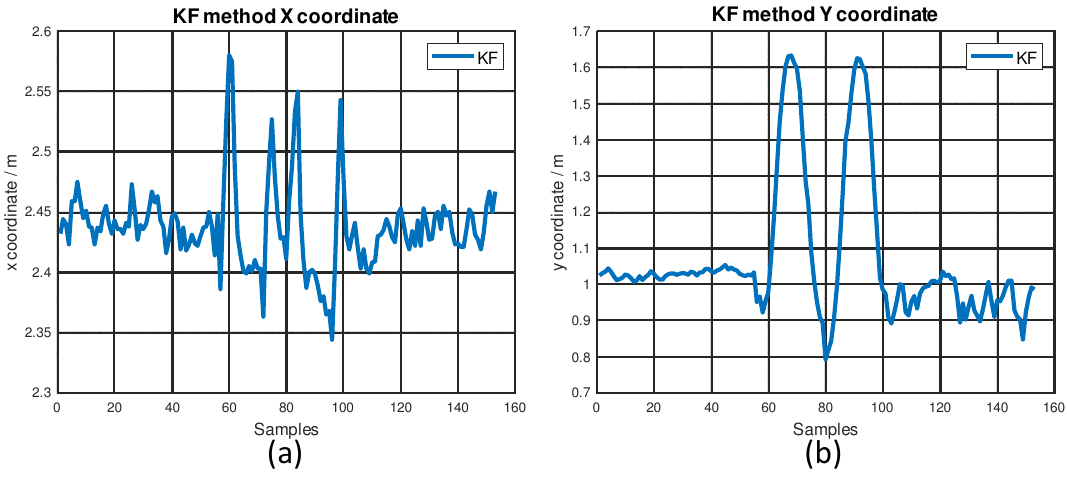
Figure 11. BNO055 acceleration data on the x -axis and y -axis. The values of x, y coordinates are shown in Figure 12. The KF sensor fusion algorithm is applied to the xy -plane. Considering the linear stage only accelerates and decelerates along the y -axis, there should be no movements along the x -axis on the ground truth trajectory. The linear stage testing platform was configured to move back and forth from one end to the other end along the y -axis; the distance it traveled was 90 cm. The ground truth on the x -axis was 2.43 m (and should remain constant during dynamic testing). The RMSE and maximum error could be calculated conveniently on the x -axis. The RMSE was only 6 cm and the maximum error was 13.7 cm on the x -axis. Considering the y coordinates kept changing under the dynamic testing conditions, we only compared the traveled distance on the y -axis. Theoretically, the ground truth traveled distance should be 0.9 m from one end to the other end. However, the experimental result was around 0.83 m. Thus, the error on the y -axis was considered to be 7 cm. Our dynamic testing results are very close to those from previous works, which are shown in Table 1. In conclusion, the KF sensor fusion of UWB and IMU can achieve an accuracy of less than 15 cm under dynamic testing conditions.